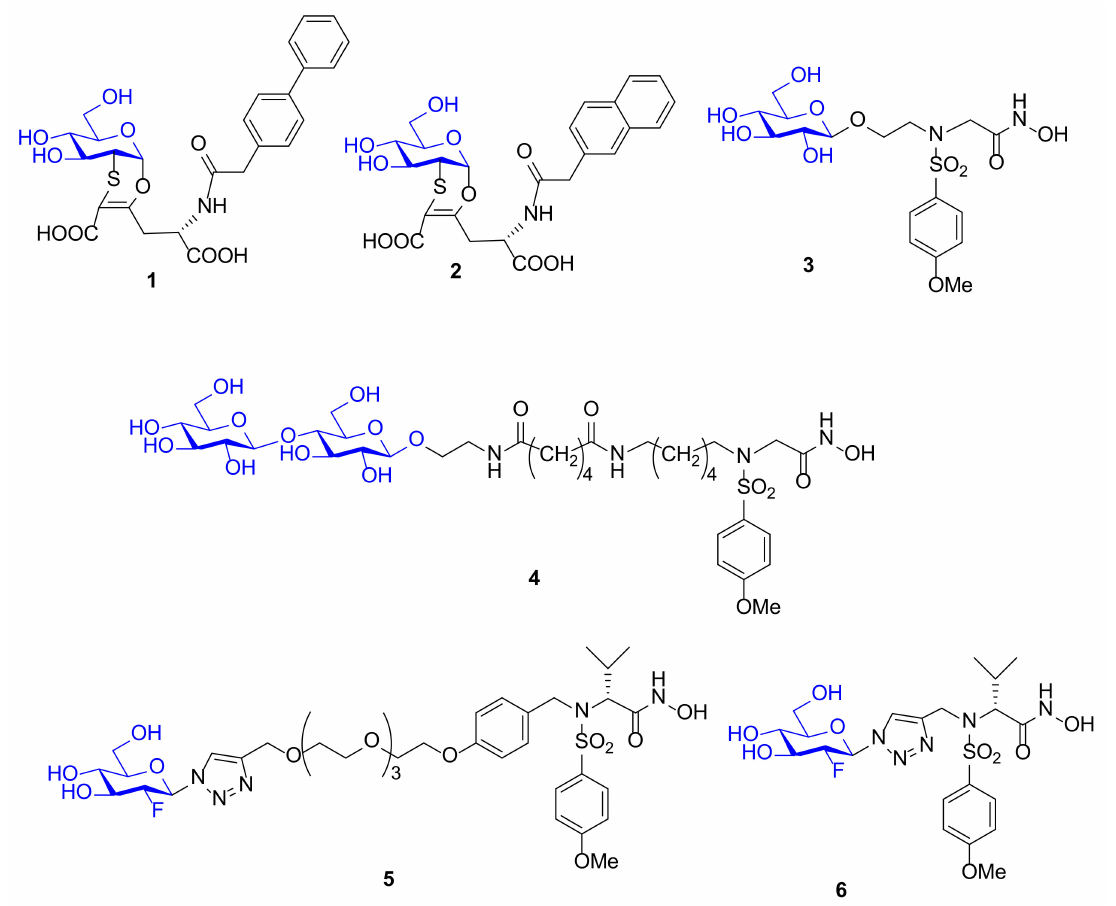
Figure 5. Chemical structure of glycoconjugated MMPIs 1–6